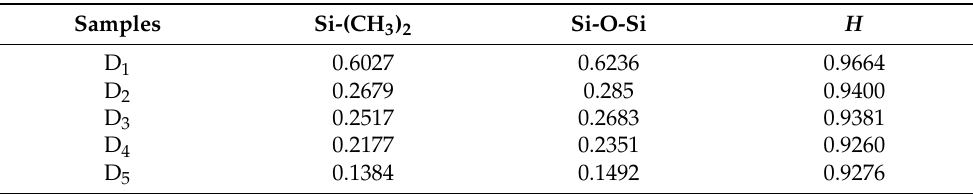
Table 6. The absorption peak height ratio of Si-O-Si and Si(CH 3 ) 2 of composite insulator in D.